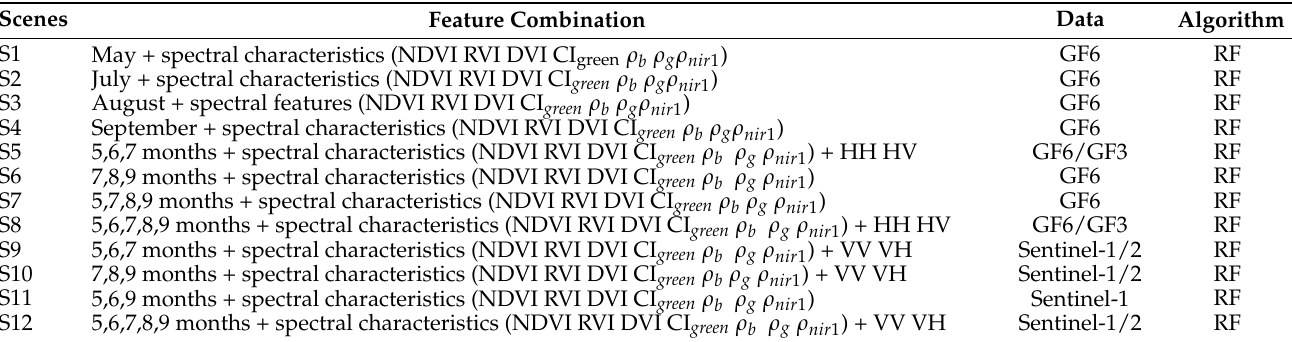
Figure 2. NDVI variation curve of different vegetation types in Zhaodong. Table 4. Classification